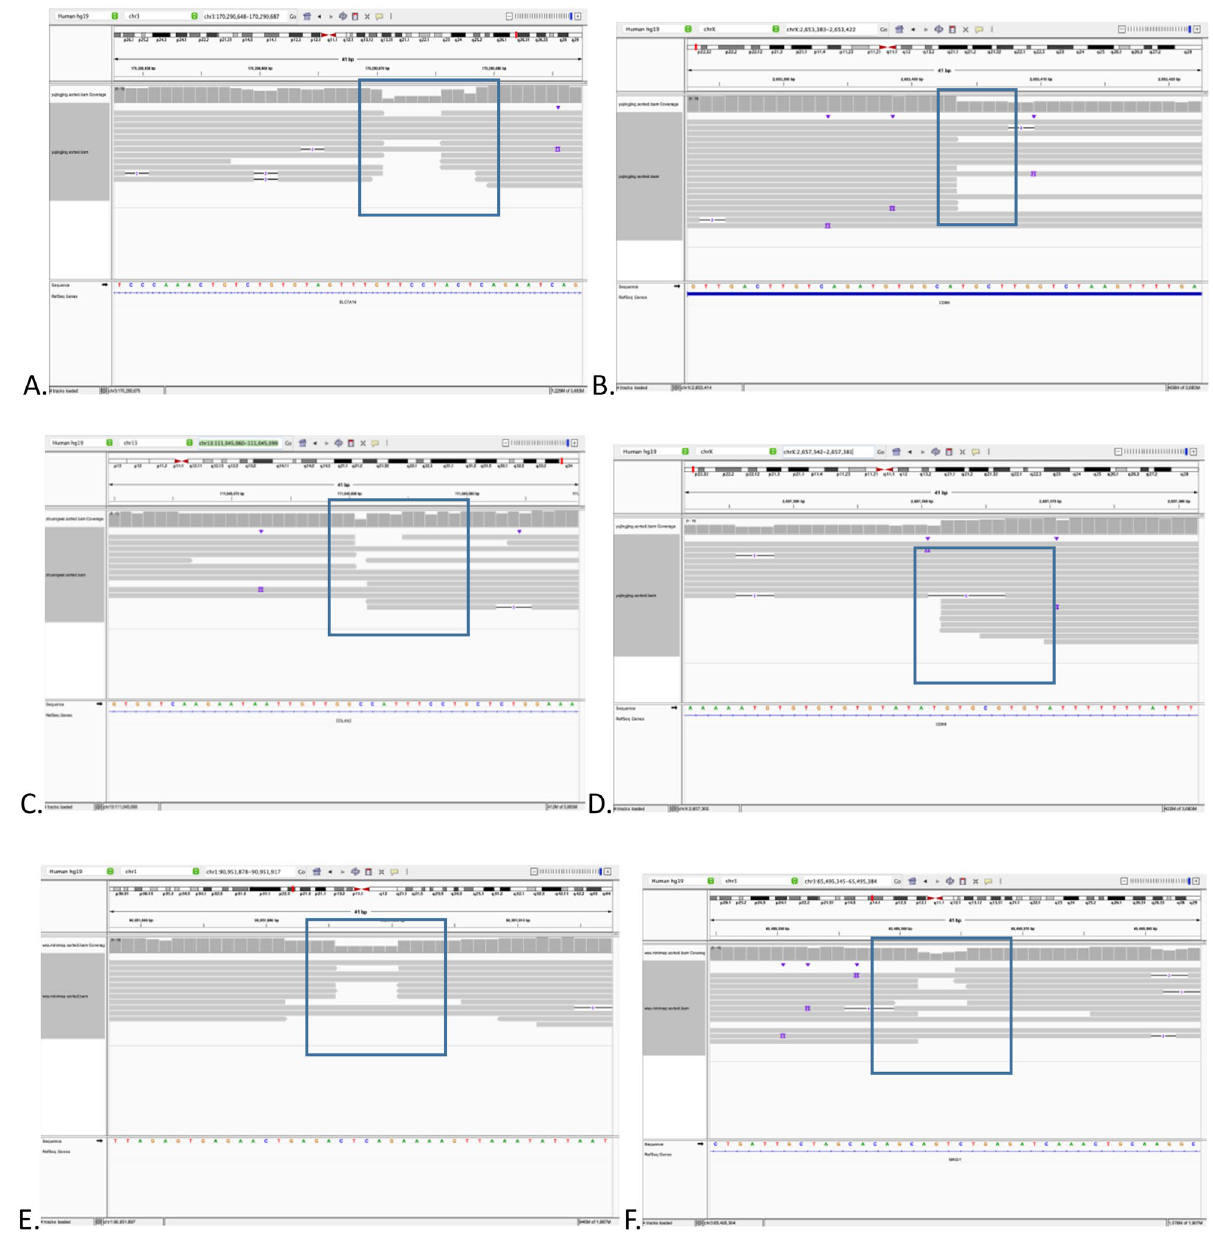
Figure 1. Long read sequencing of translocation breakpoints in samples 1–2 and the base sequences around the breakpoints are shown in the IGV, the area in the red box is the breakpoint reads. Colored capital letters at the bottom of the IGV represent base information. Reads breakpoint location display in IGV: ( A ) chr3: 170290668–170290678. ( B ) chrX:2653403–2657362. ( C ) chr13: 111045080–111045082. ( D ) chr16: 46392636–